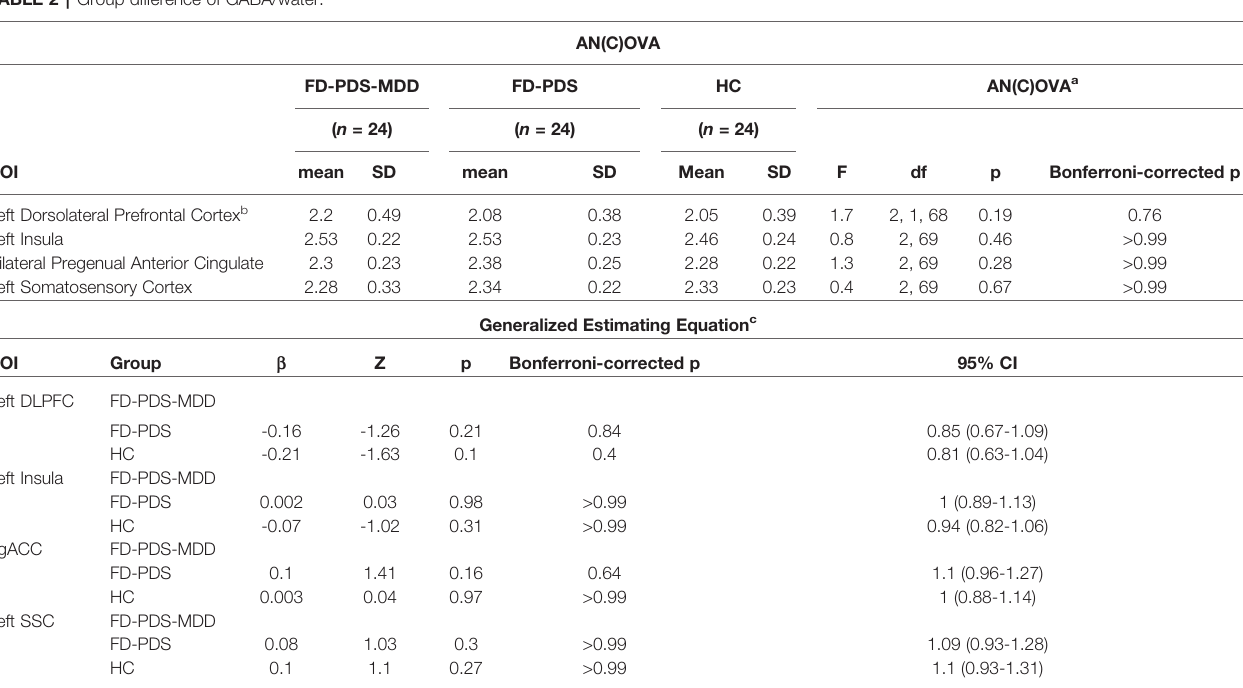
FIGURE 2 | Group difference in GABA/water in four regions of interest: left dorsolateral prefrontal cortex, left insula, bilateral pregenual anterior cingulate cortex, and left somatosensory cortex. TABLE 2 | Group difference of